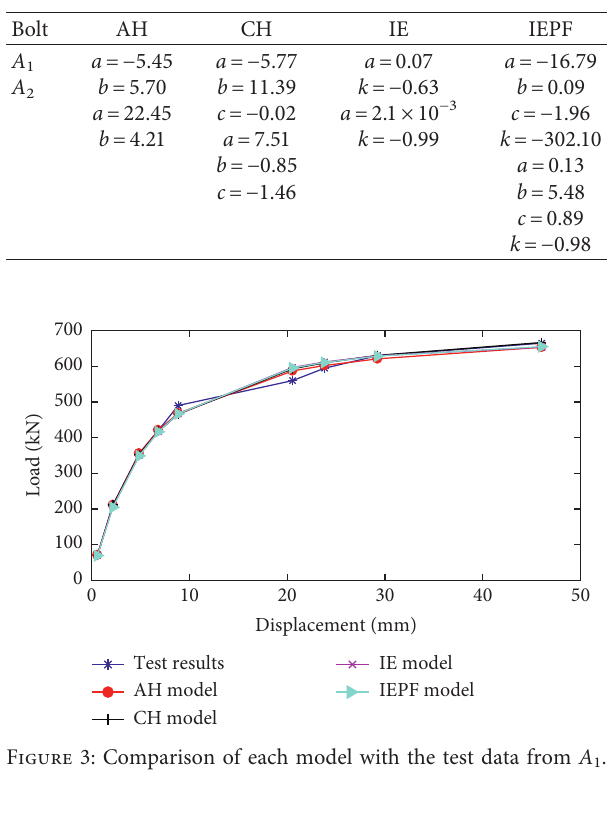
Table 2: Model parameters for example 1.